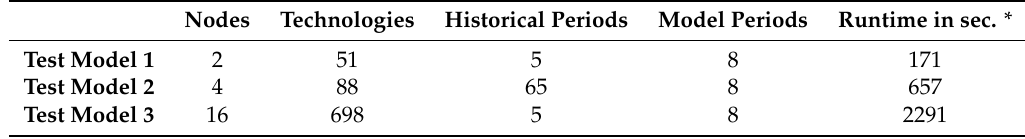
Table 2. d2ix model-creation performance tests with different models. Calculations were performed